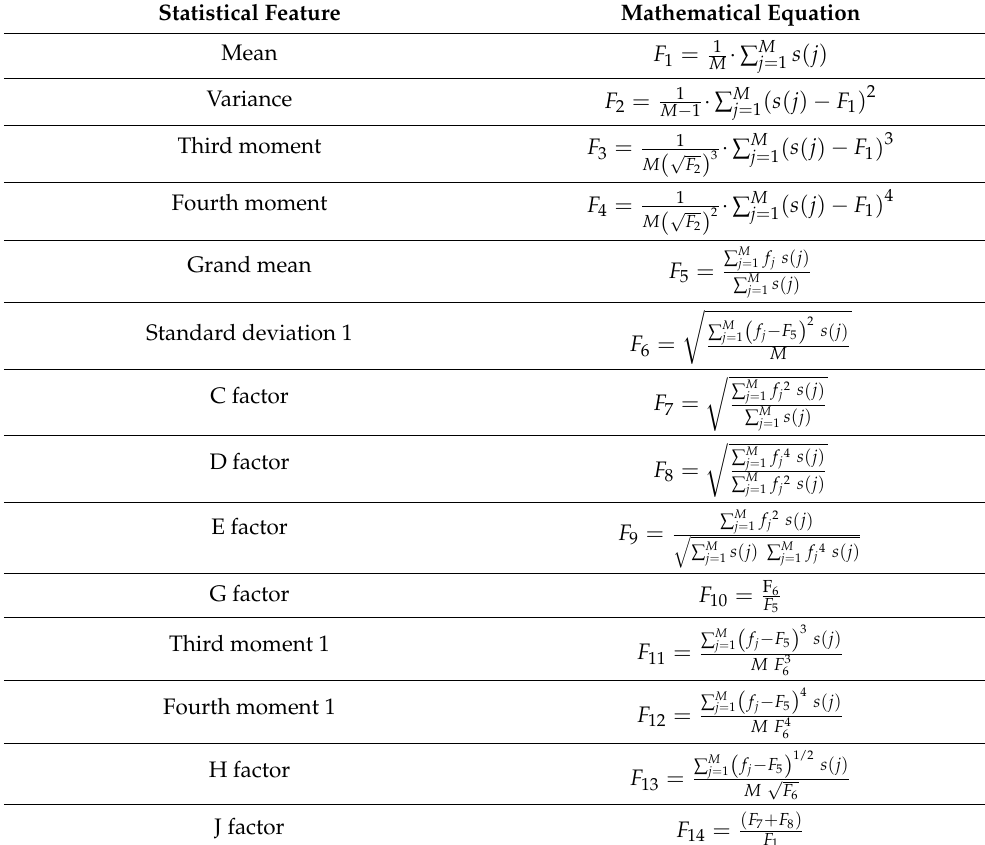
Table 3. Proposed set of statistical features for the characterization of frequency spectra estimated from each available signal during its processing in the frequency-domain analysis, where s ( k ) is a spectrum for j = 1, 2, . . . , M , and M is the number of lines with f j as the frequency value of the j th spectrum